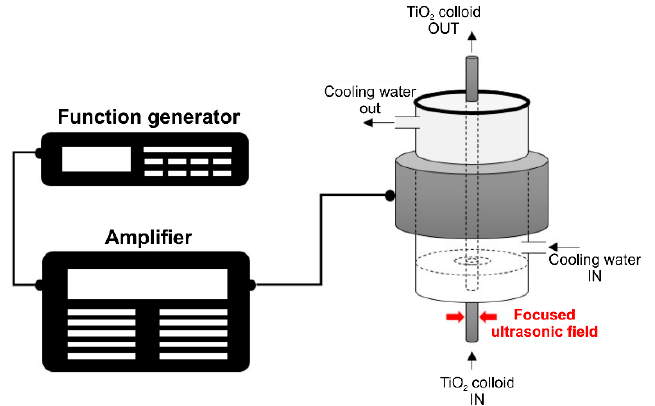
Figure 1. Schematic of the ultrasonic dispersion equipment employed in this study.